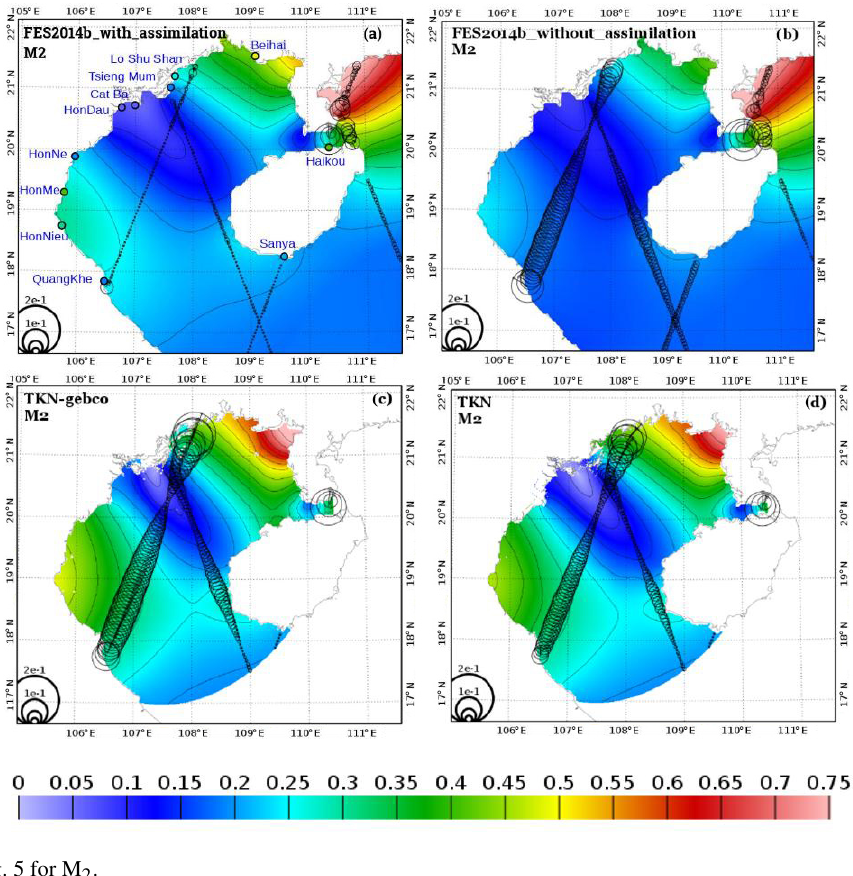
Figure 7. Same as Fig. 5 for M 2